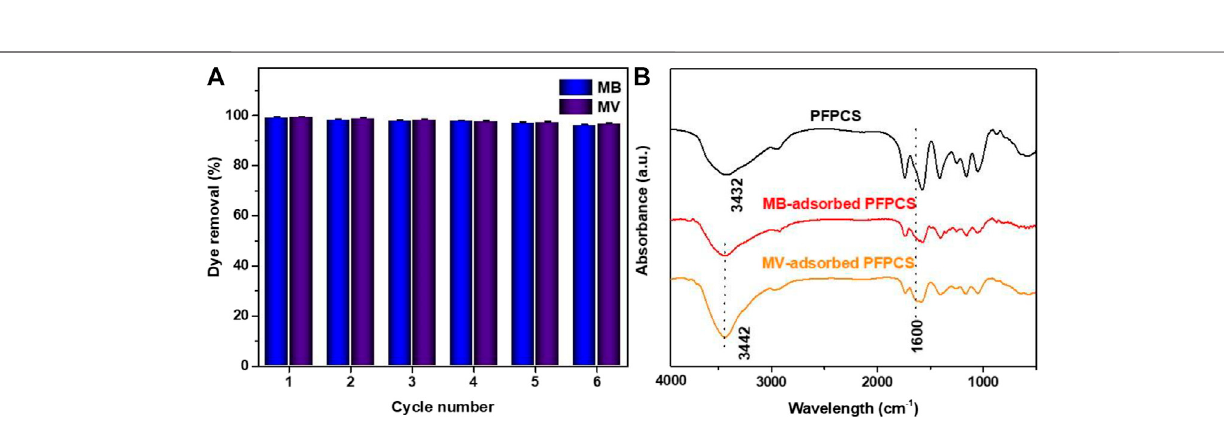
Frontiers in Chemistry |